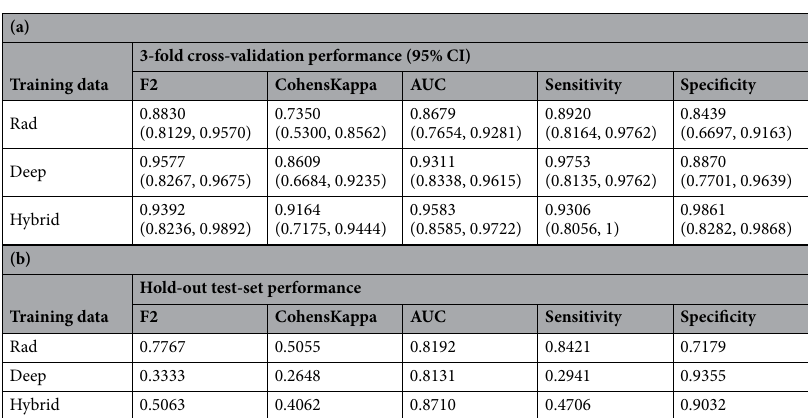
Table 3. 3-fold cross-validation, (a), and hold-out test set performance, (b), of classifiers trained with radiomic, deep and hybrid